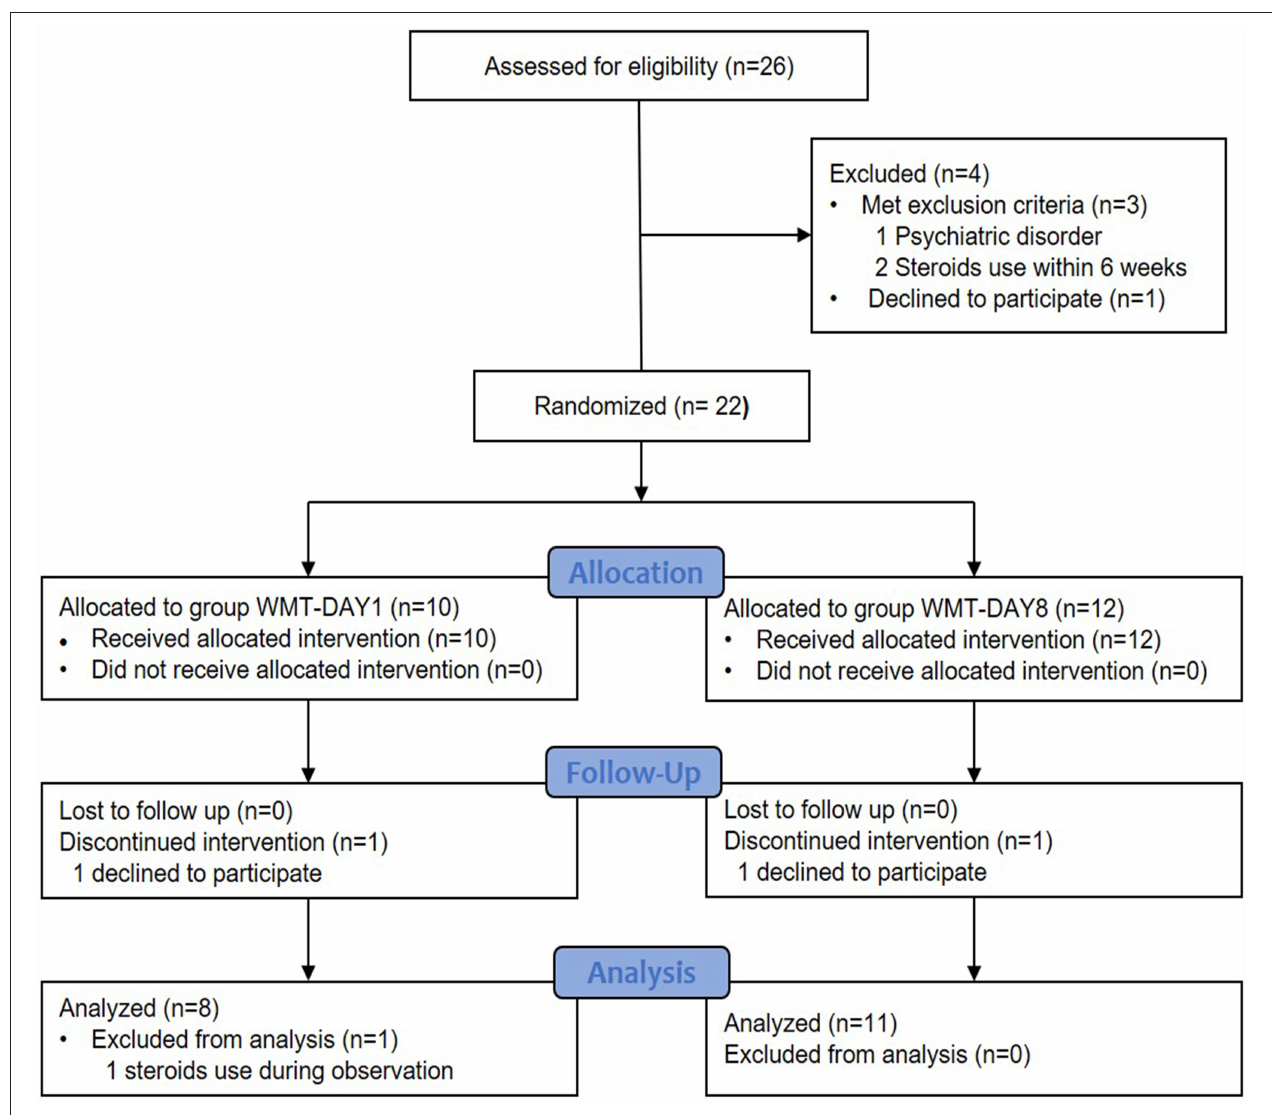
FIGURE 1 | Flow of patients in the trial. WMT, washed microbiota